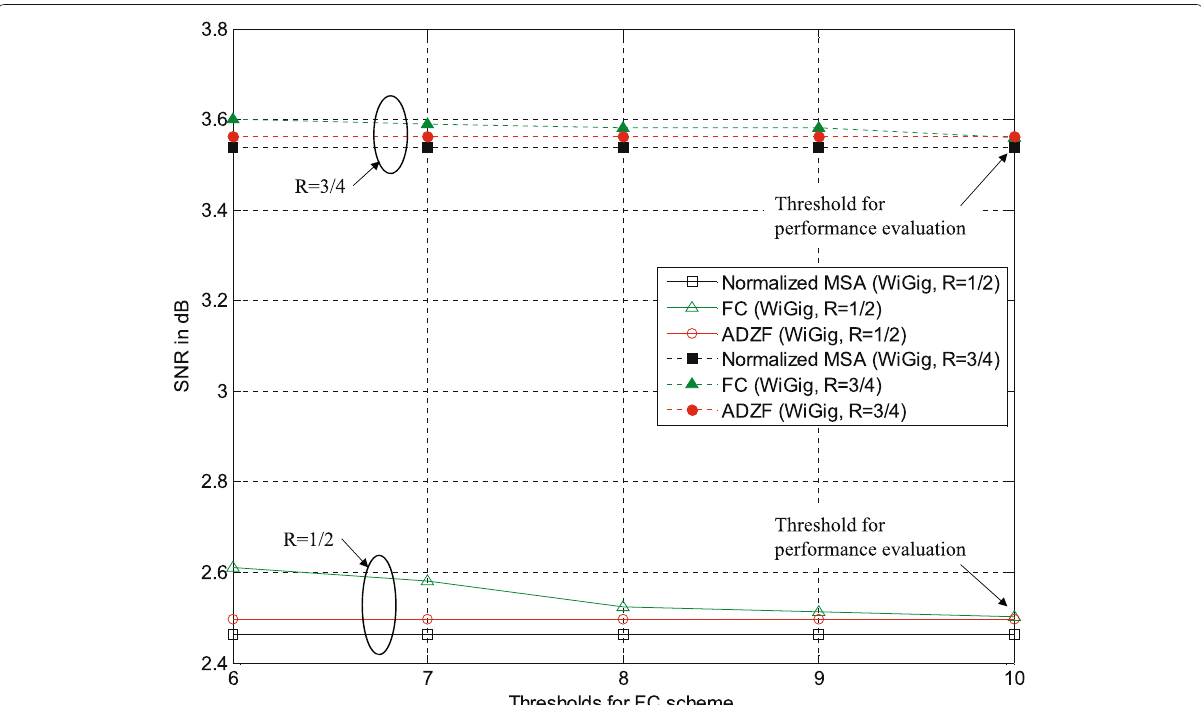
Fig. 12 Average number of iterations of the normalized min-sum algorithm, conventional FC scheme with various threshold values, and proposed algorithm (ADZF) where I max = 20 and FER = 10 −